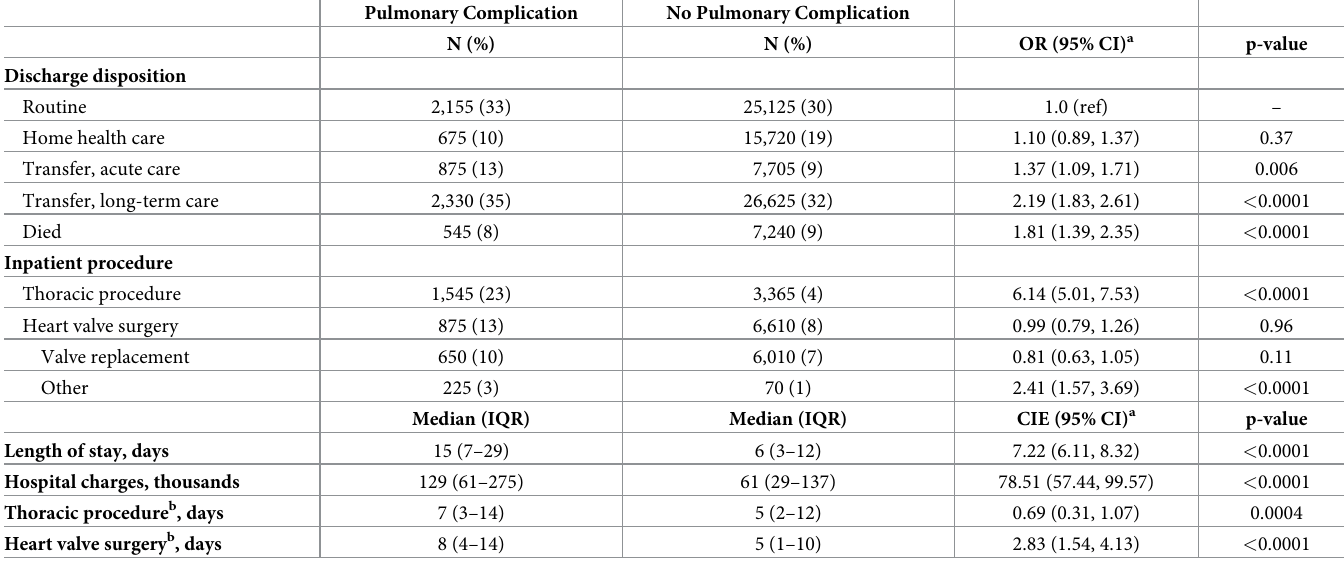
Table 2. Association of pulmonary complications and inpatient